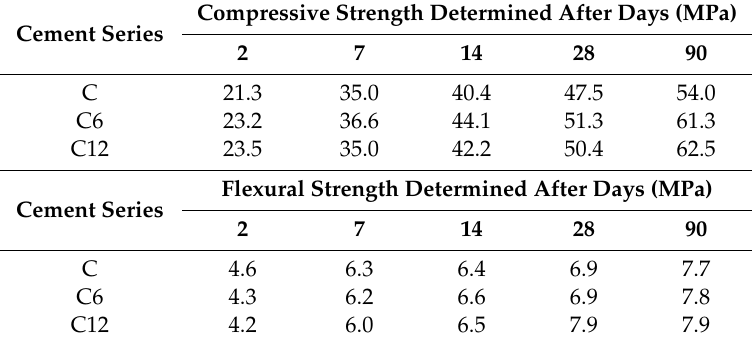
Table 4. Strength characteristics of tested